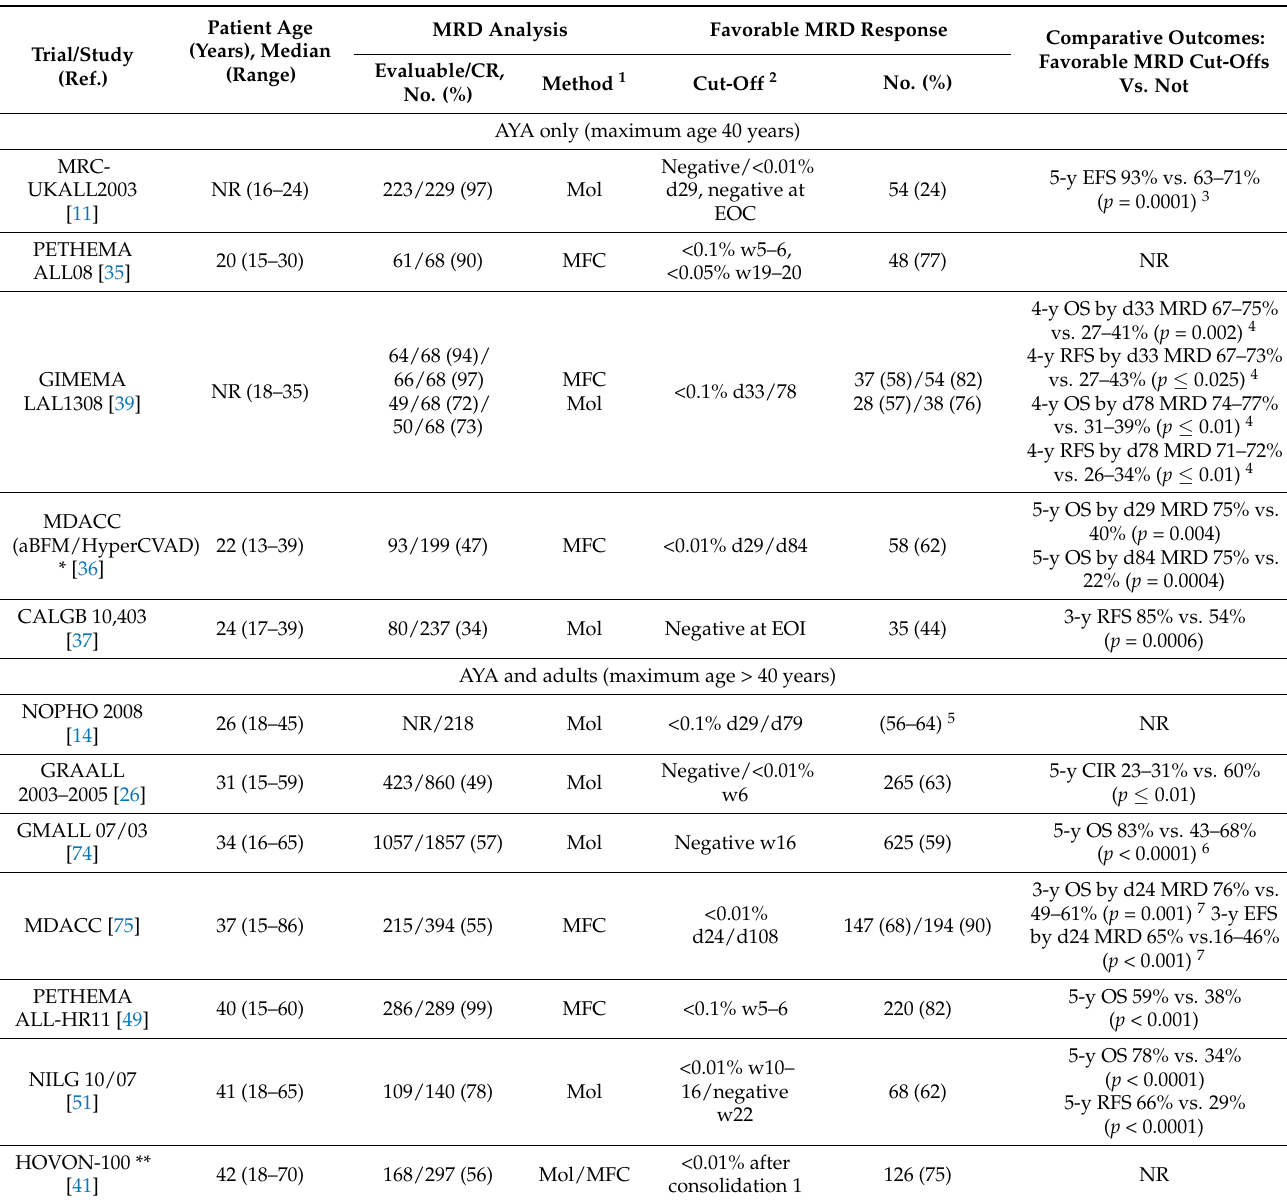
Table 4. MRD pos -based results (risk stratification, risk-oriented therapy and clinical outcome) in AYA and adult Ph − ALL trials.